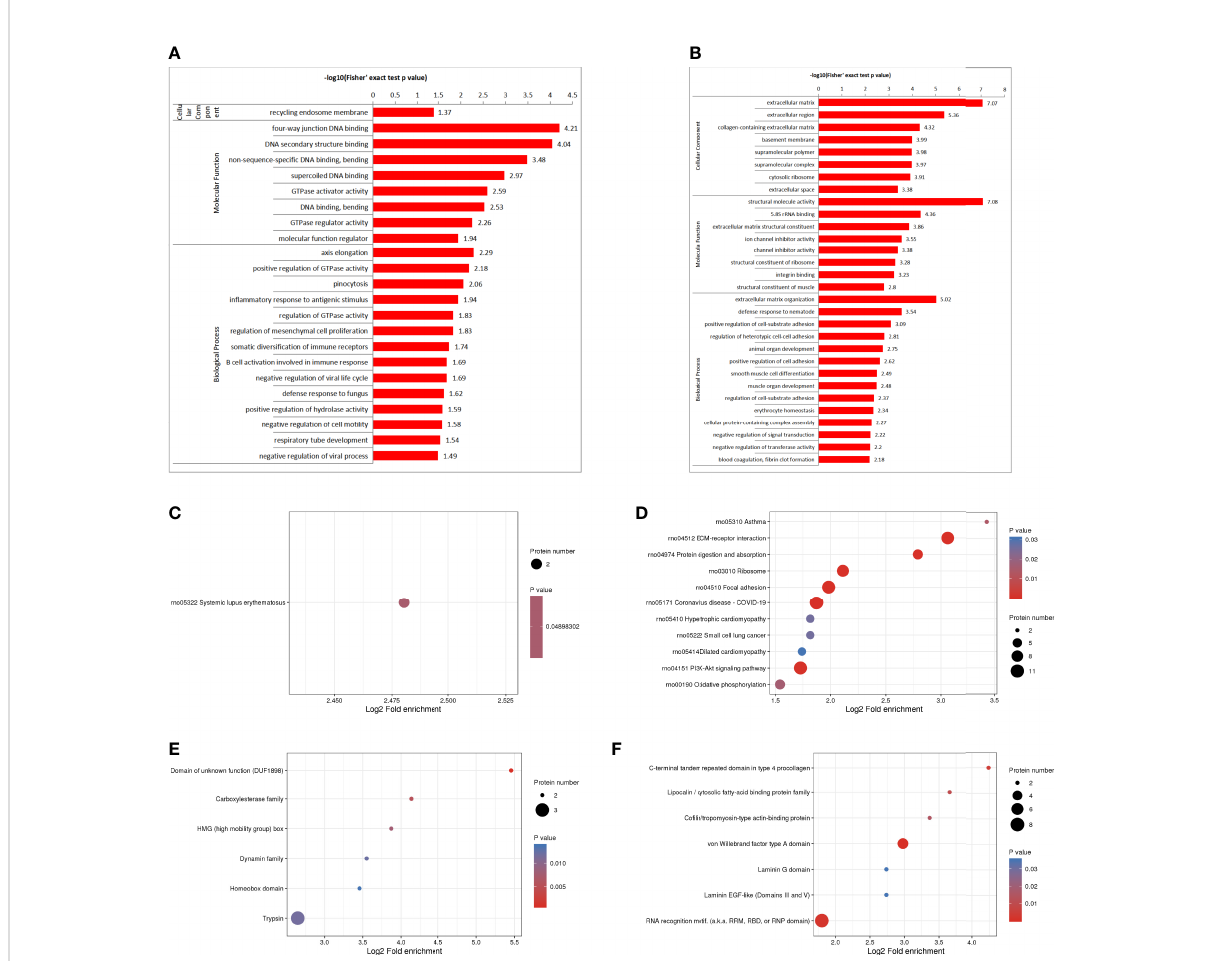
FIGURE 3 DEPS enrichment analysis. GO enrichment, up-regulated DEPS enrichmen (A) . GO enrichment, down-regulated protein enrichment (B) . KEGG enrichment of up-regulated DEPS (C) . KEGG enrichment of down-regulated DEPS (D) . Enrichment of important protein domains in upregulated DEPS (E) . Enrichment of important protein domains in downregulated DEPs (F)